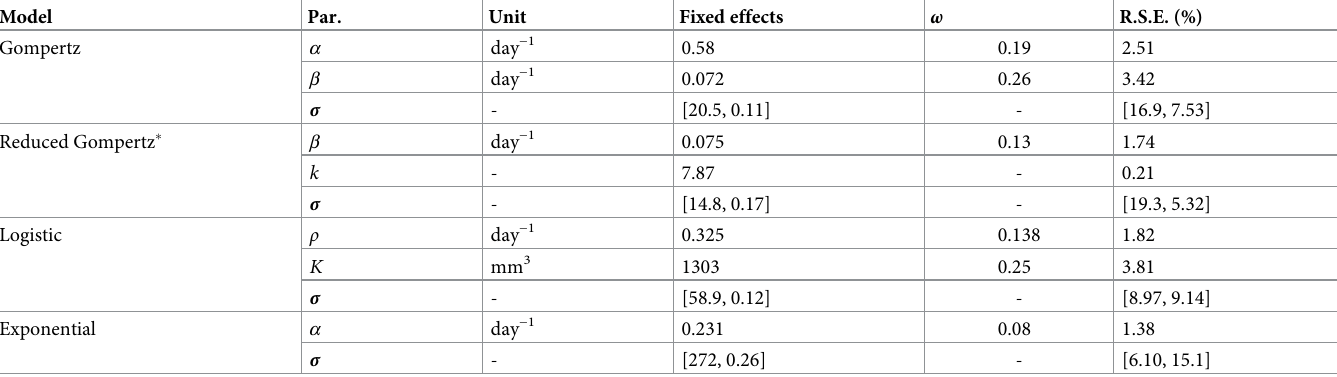
Table 2. Fixed effects (typical values) of the parameters of the different models. Par. = parameter. ω = standard deviation of the random effects. R.S.E. = relative stan- dard errors of the estimates. σ = residual error model parameters. � The reduced Gompertz model is introduced below. Model